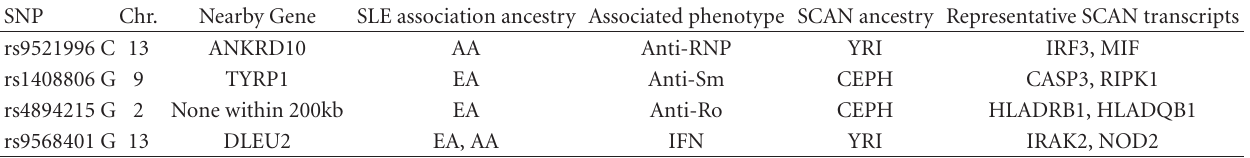
Table 2: Summary of the 4 SNPs associated with SLE phenotypes and the SCAN database results regarding ancestral background and representative associated